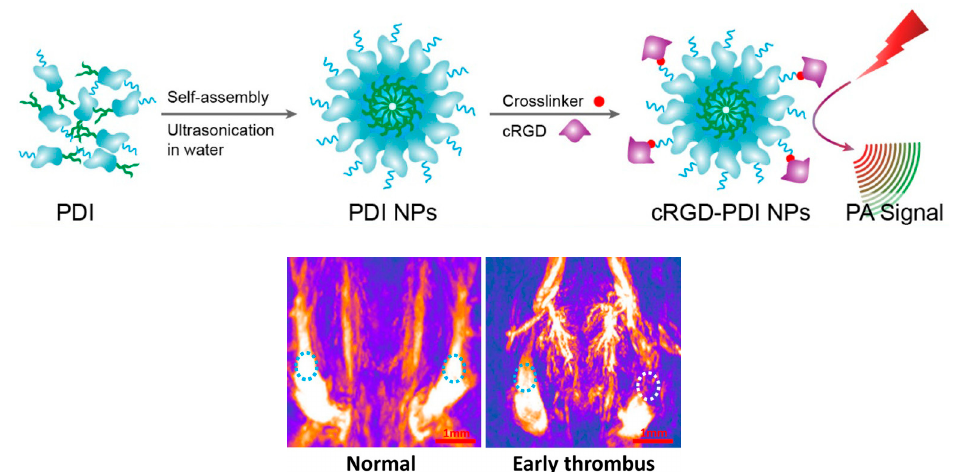
Figure 21. Schematic illustration of the preparation of cRGD-PDI NPs; PAI showed normal jugular veins (in blue circle) and jugular veins with early thrombus (in white circle). ( Left ): normal mice. ( Right ): thrombus model. Reprinted with permission from Ref. [132]. Copyright 2017 American Chemical Society.